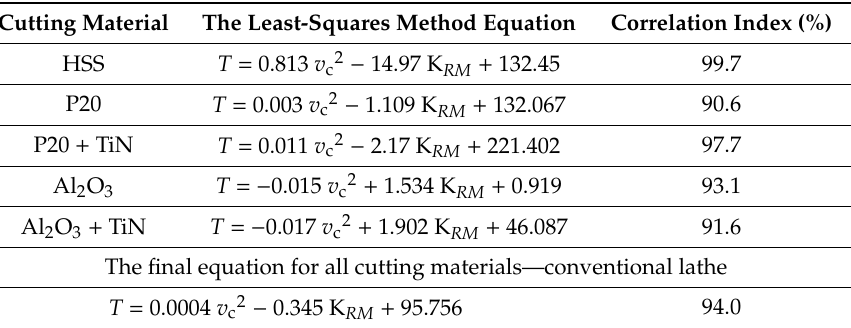
Table 11. T-v c equations for the conventional lathe.